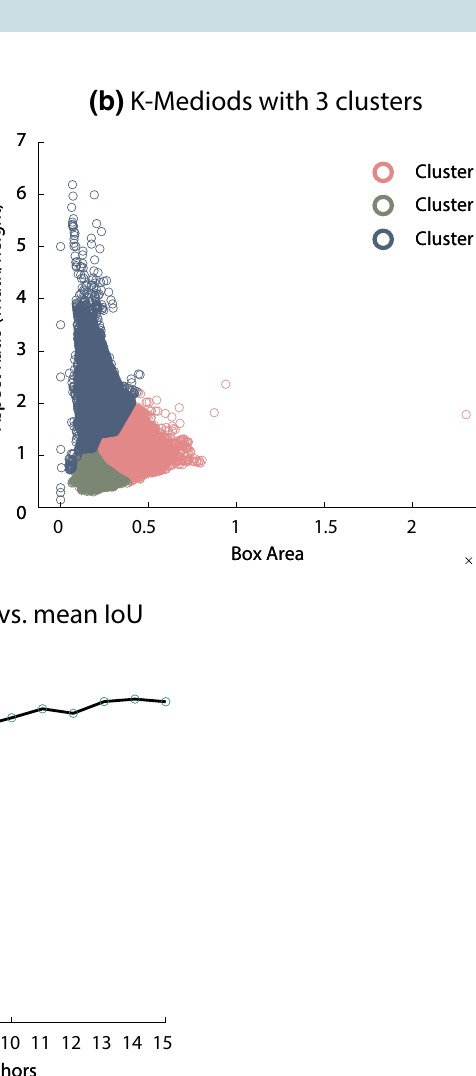
Figure 2. Estimation of anchor boxes using the K-Medoids clustering algorithm. ( a ) shows the ground truth box distribution of our training data with respect to box aspect ratio and box area. ( b ) visualises three clusters, obtained using the K-Medoid algorithm, from which three anchor boxes were selected. ( c ) exhibits the trade- off between the number of anchor boxes (a maximum of 15; x-axis) and the mean IoU (y-axis) of each subset anchor boxes.